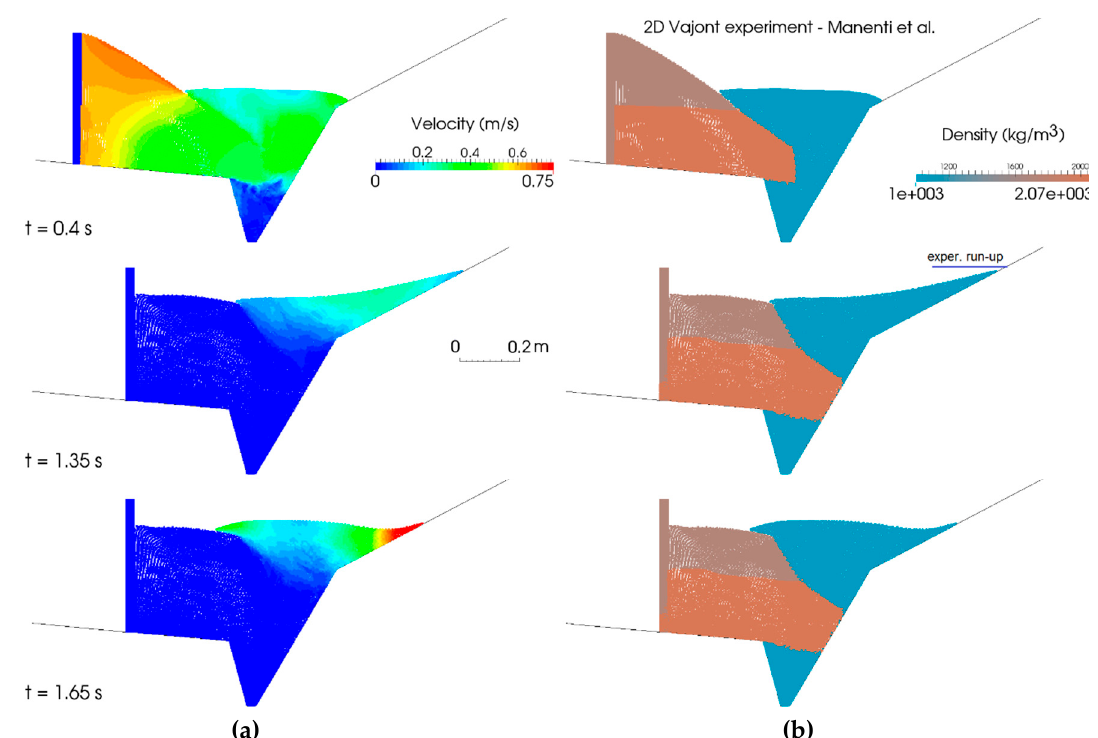
Figure 5. Frames of the simulation of the Padua experiment. ( a ) Velocity field; ( b ) Density field.